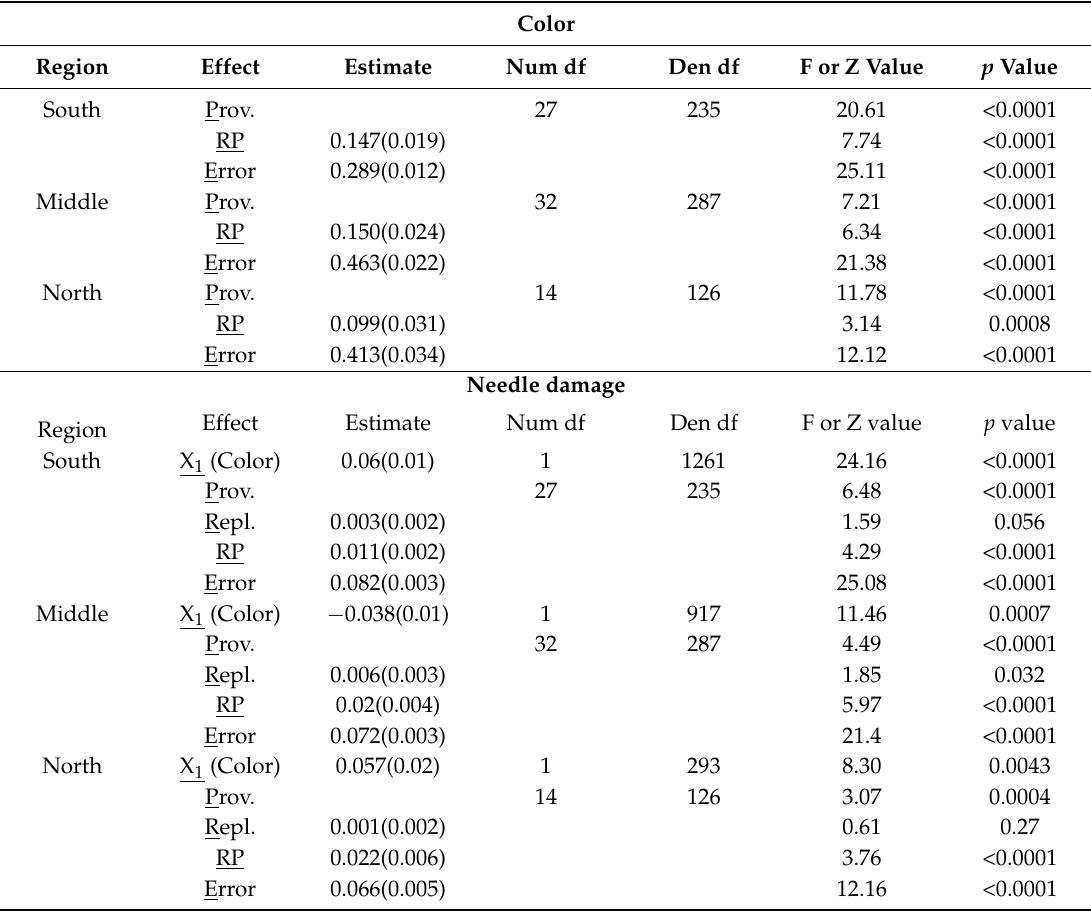
Table 1. Parameters from the analysis of variance (and covariance) for needle color and damage caused by D. abietis in the provenance trial at Jønsberg. Parameters given are: Estimate, the variance (with standard error) for random effects and the b (beta) for the covariate X 1 ; the degrees of freedom (df) of the numerator (Num) and denominator (Den) in the test of the fixed provenance (Prov.) effect; F or Z values for fixed or random effects, respectively; and p values for the test of significance. As the values for needle color were normal score transformed within replicates, parameters for replicate (R) were not possible to estimate. RP = interaction between provenance and